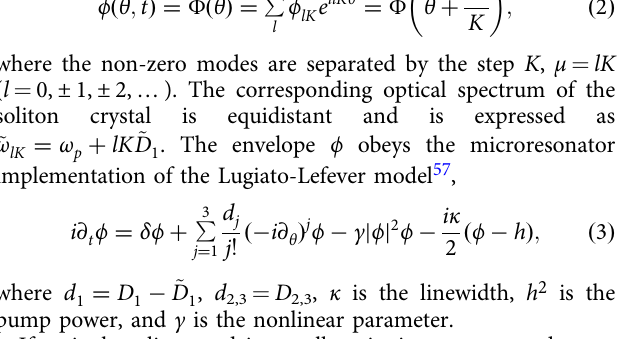
κ = 5 × 10 − 4 , d κ = 5 × 10 − 7 , and δ / κ = 30. The crystal repetition rates vary with 2 / 3 /